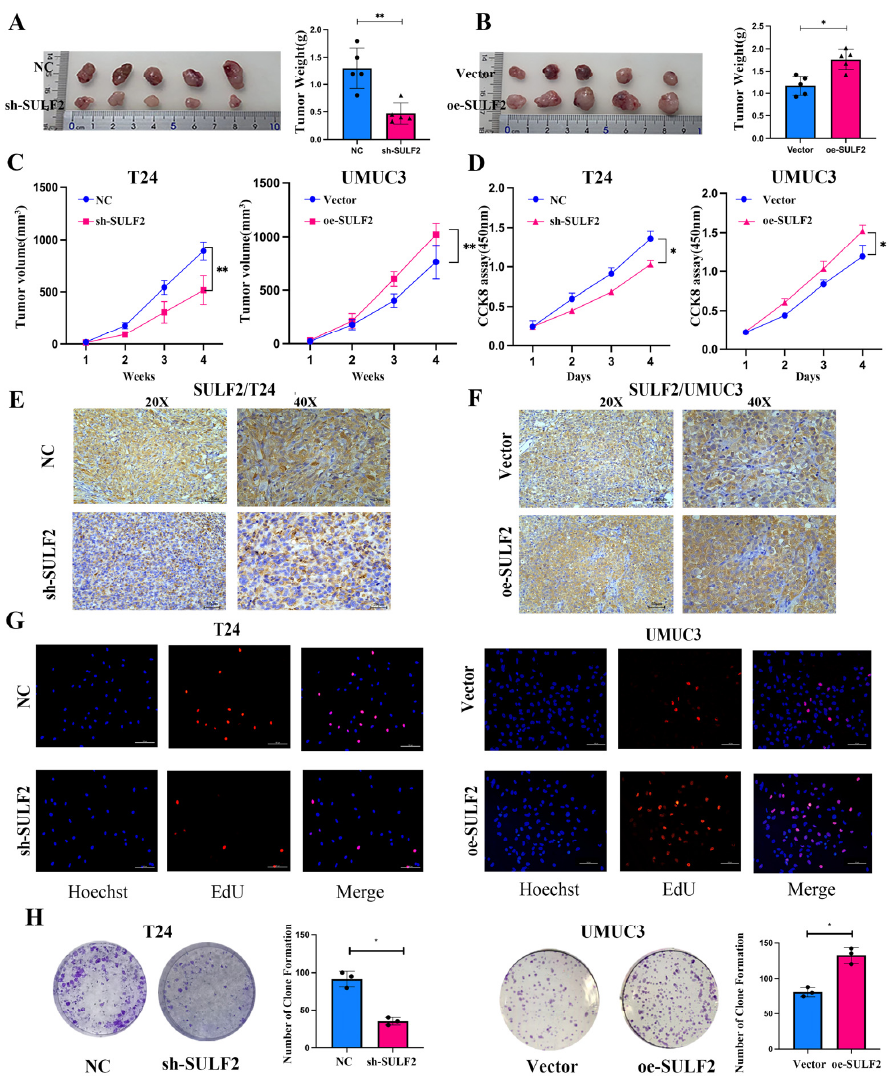
Figure 3. SULF2 affects proliferation of BCa cells. ( A , B ) For nude mouse xenograft assay, sh-SULF2, oe-SULF2, and negative control BCa cells were subcutaneously injected into nude mice and monitored for one month for tumor cell xenograft formation and growth. The right is tumor cell xenograft weight. ( C ) Analysis of tumor growth for the subcutaneous xenotransplant tumor models. ( D ) Cell proliferation was detected by CCK8 assay at 24, 48, 72, and 96 h. ( E , F ) Representative images of SULF2 in tumor cell xenograft by IHC staining. ( G ) Representative images of EDU assay of sh-SULF2, oe-SULF2, and negative control BCa cells. ( H ) Knockdown or overexpression of SULF2 affects the cell colony formation ability. The right panel shows the number of colonies of cloned cells. Data are represented as mean ± SD of three experiments. * p < 0.05, ** p < 0.01.